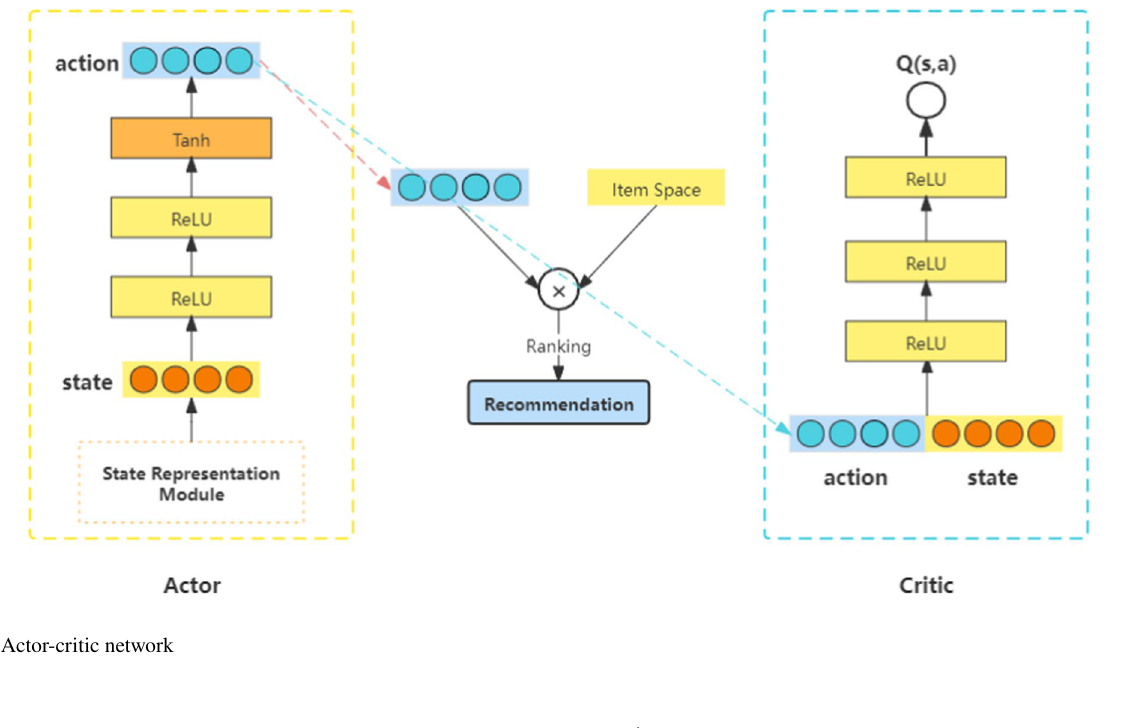
Fig. 2 Actor-critic